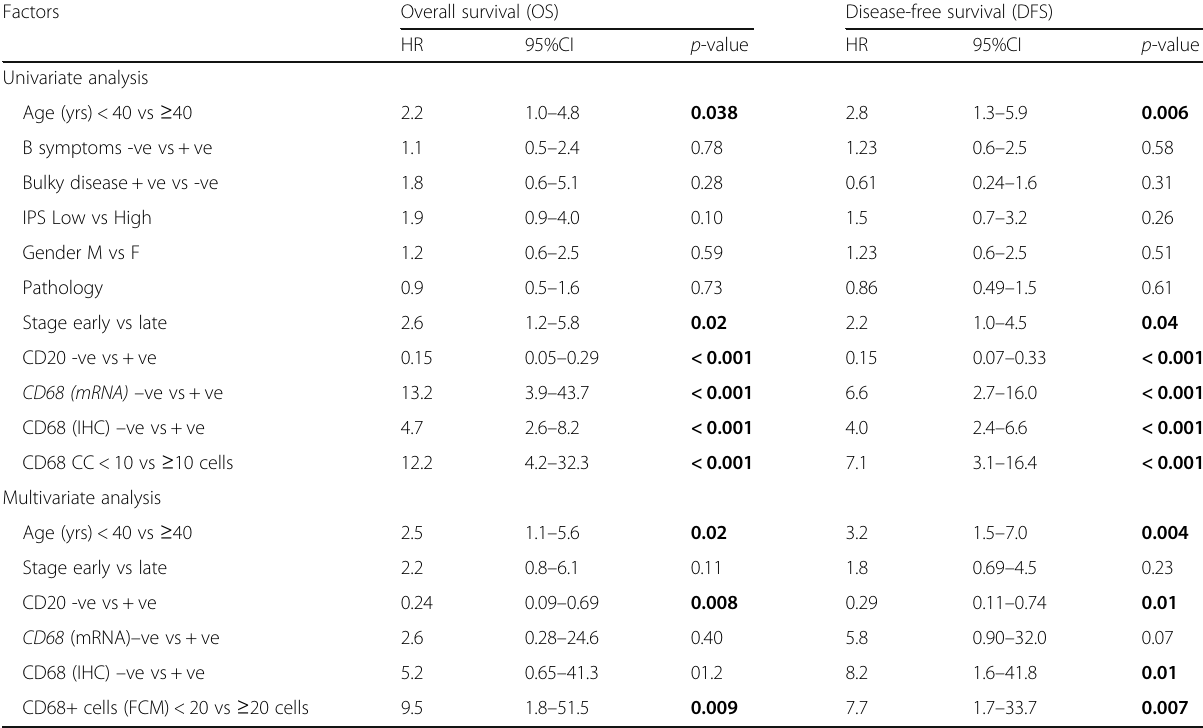
Table 5 univariate and multivariate analysis for OS and DFS of the patients Factors